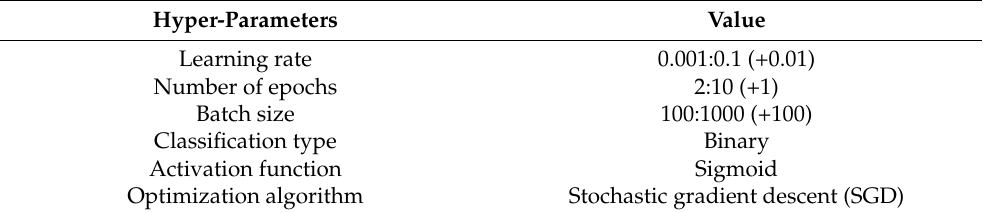
Table 1. The hyper-parameters used in the proposed detection